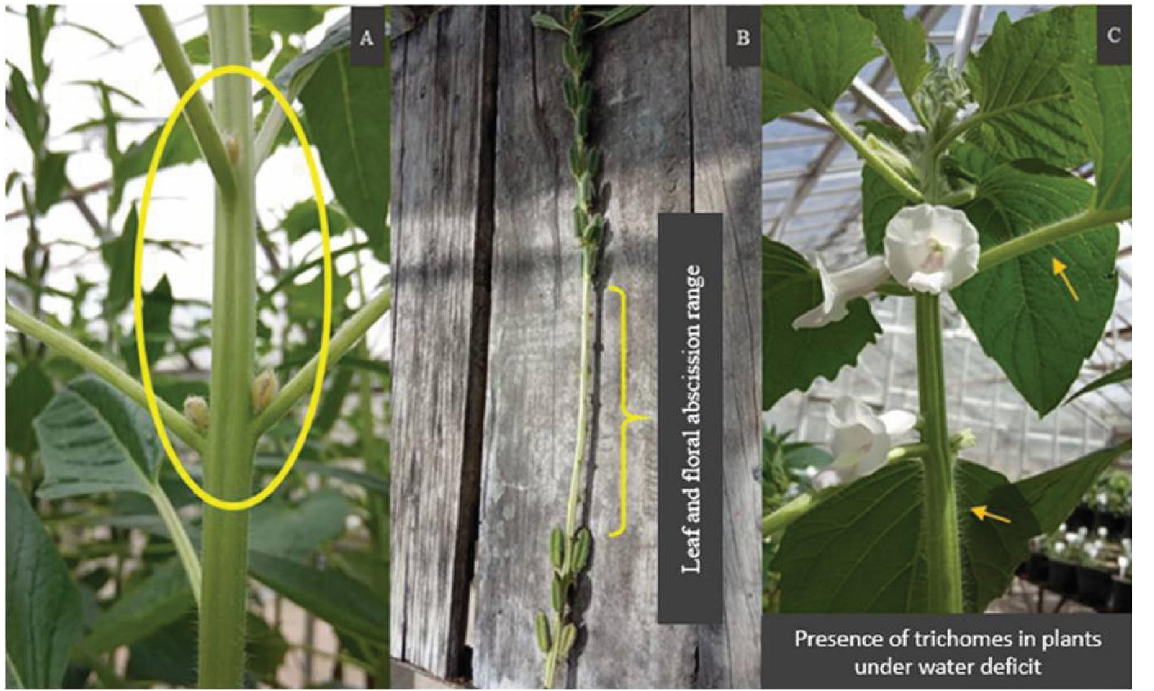
Figure 3. Observation of the events caused by water deficit in plants at BRS Anahí: ( A ) floral abor- tion; ( B ) leaf and floral abortion interval; and ( C ) presence of trichomes.